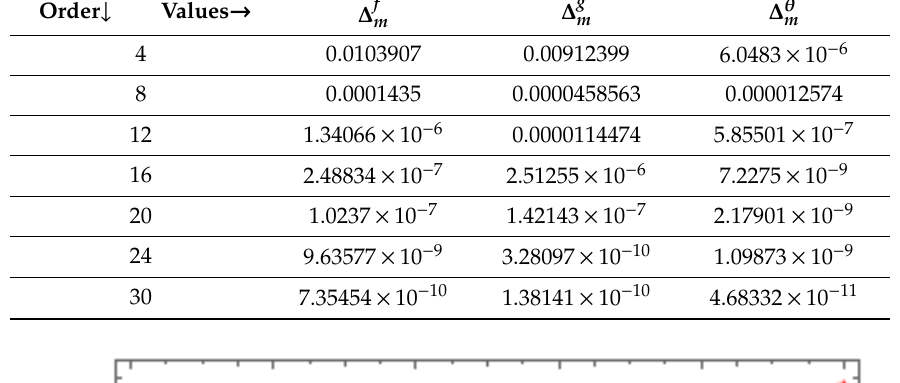
Table 5. Individual residual square errors for ∆ f m , ∆ g m , ∆ θ m .